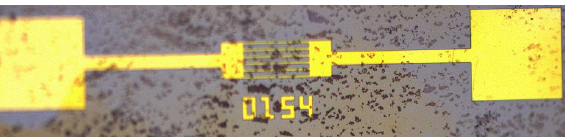
Figure 2. A picture of microelectrodes used for growing ZnO nanowires.